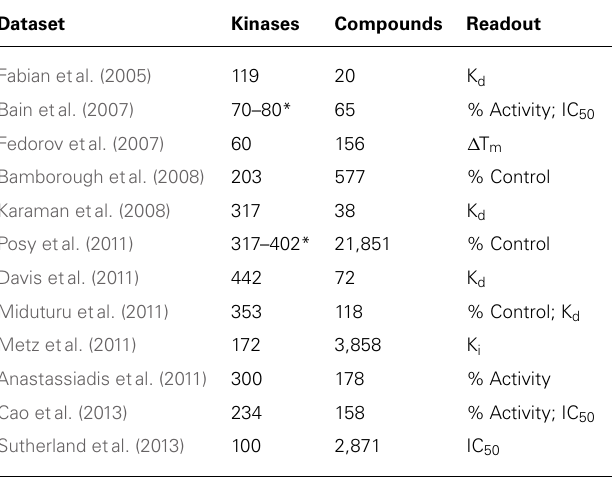
Table 1 | Kinase/inhibitor profiling